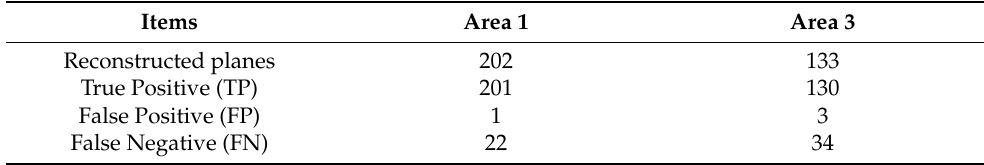
Table 1. Quantitative assessment of plane extraction. Items Area 1 Area 3 Reconstructed planes 202 133 True Positive (TP) 201 130 False Positive (FP) 1 3 22 34